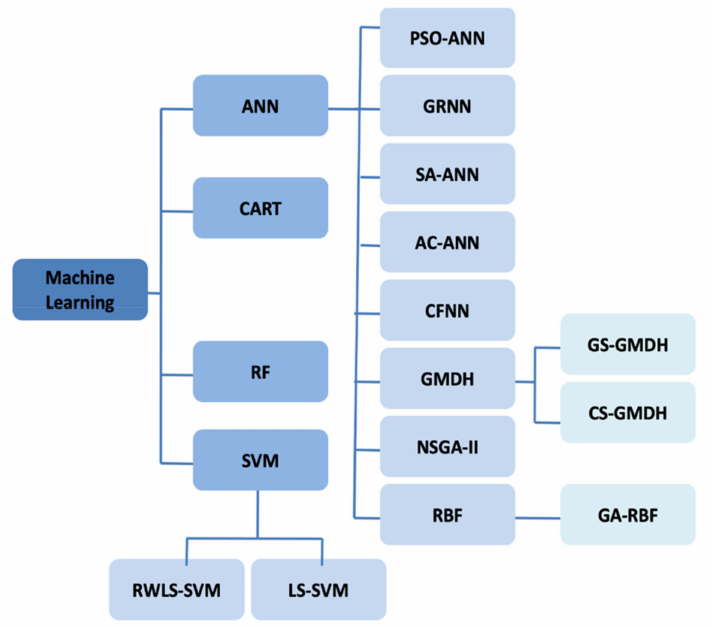
Figure 6. Categories of prediction and regression machine learning algorithms (Adapted and abridged from [92].